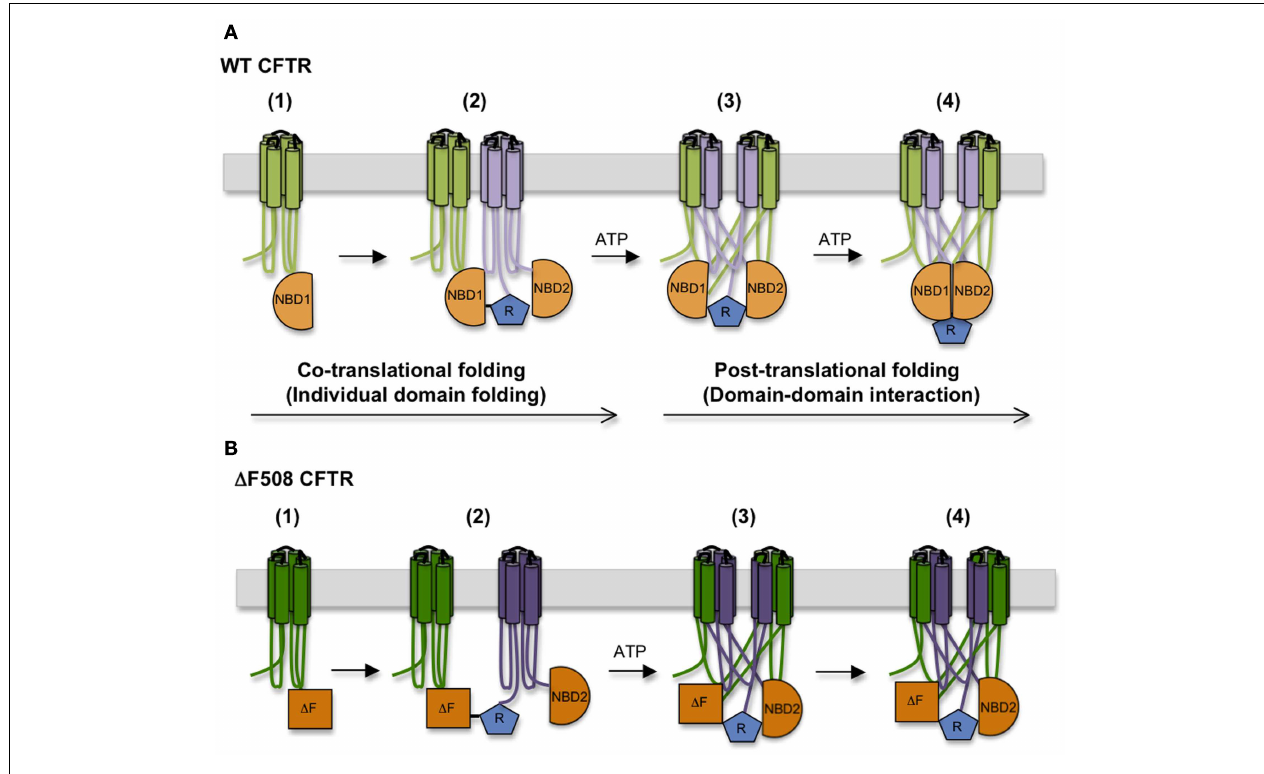
destabilizes NBD1 structure, interferes with theTMD1,TMD2, and NBD2 folding, and disturbs interactions between NBD1 and ICL4, compromising domain–domain